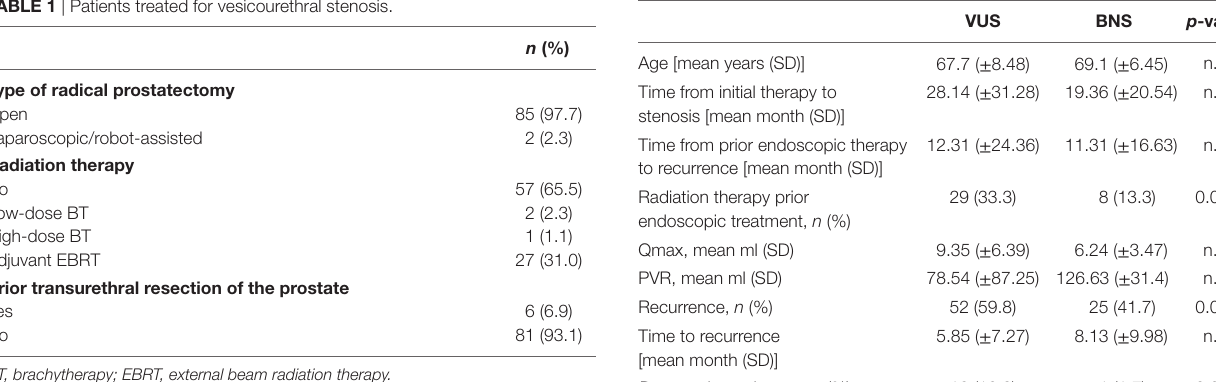
TaBle 3 | Comparison of patients treated for VUS and BNS.